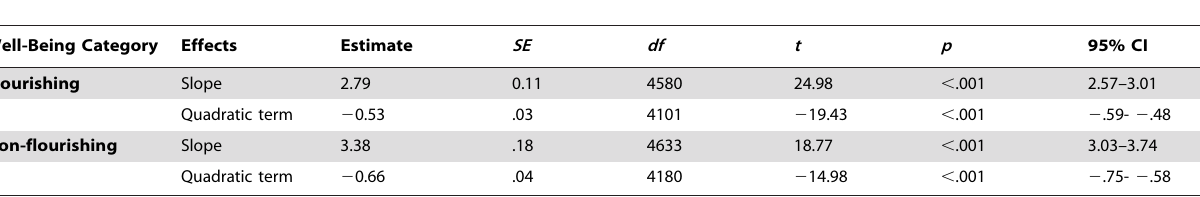
Table 5. Effect estimates for categorically measured well-being predicting depressive